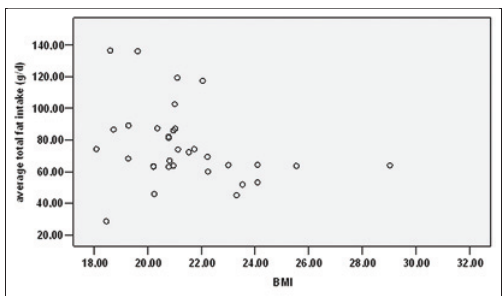
FIGURE 2. Link between BMI and total fat intake in female